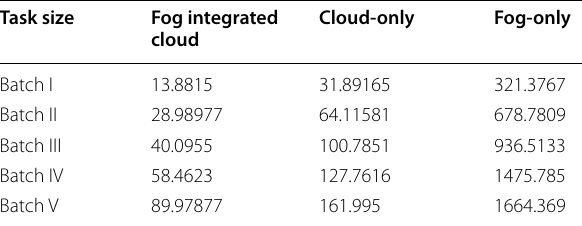
Table 7 ECT v/s batch size for IJFA for fog integrated cloud, cloud-only and fog-only architectures Task size